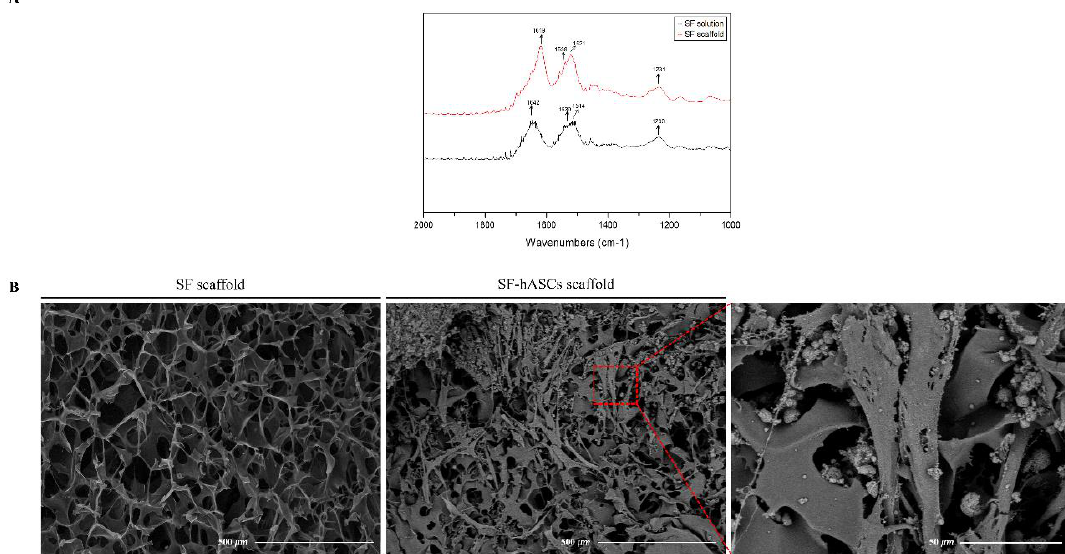
Figure 2. Characterization of silk fibroin (SF) scaffold. ( A ) FTIR spectra of SF; ( B ) morphology of SF